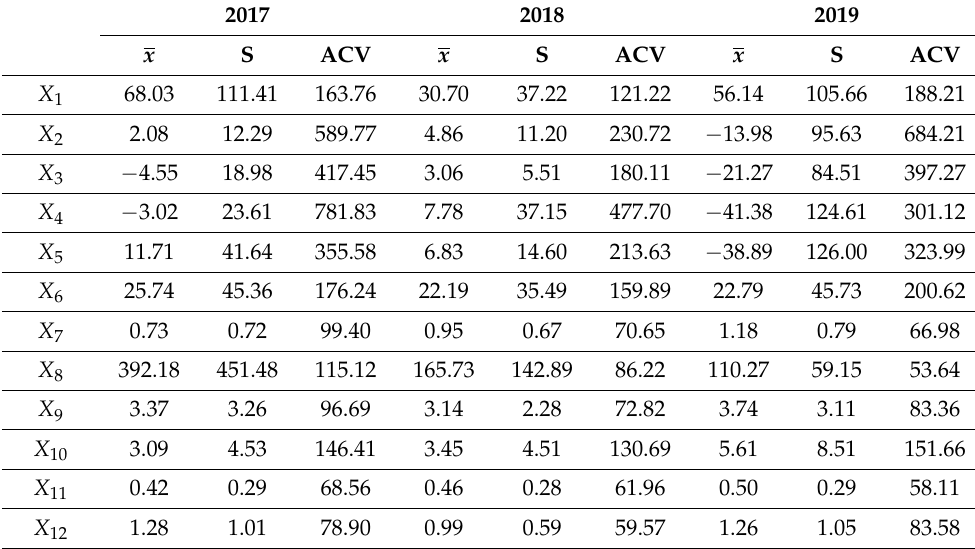
Table 3. Descriptive statistics of diagnostic